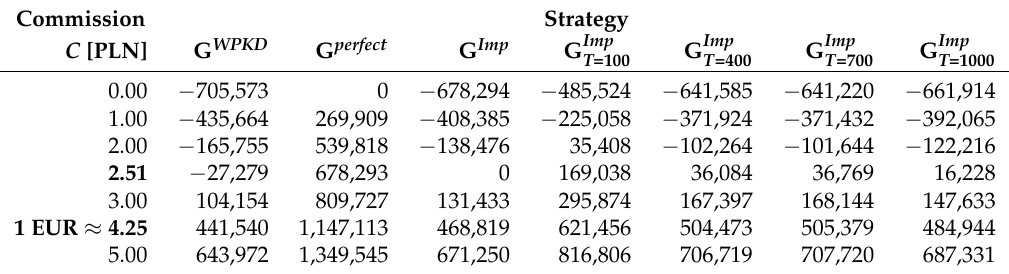
Table 1. Comparison of total profits for the different strategies considered and the whole two-year out-of-sample evaluation period, see Figures 1 and 2. Two values of C are emphasized in bold: 2.51 PLN, which yields a zero profit for the G Imp strategy, and 1 EUR ≈ 4.25